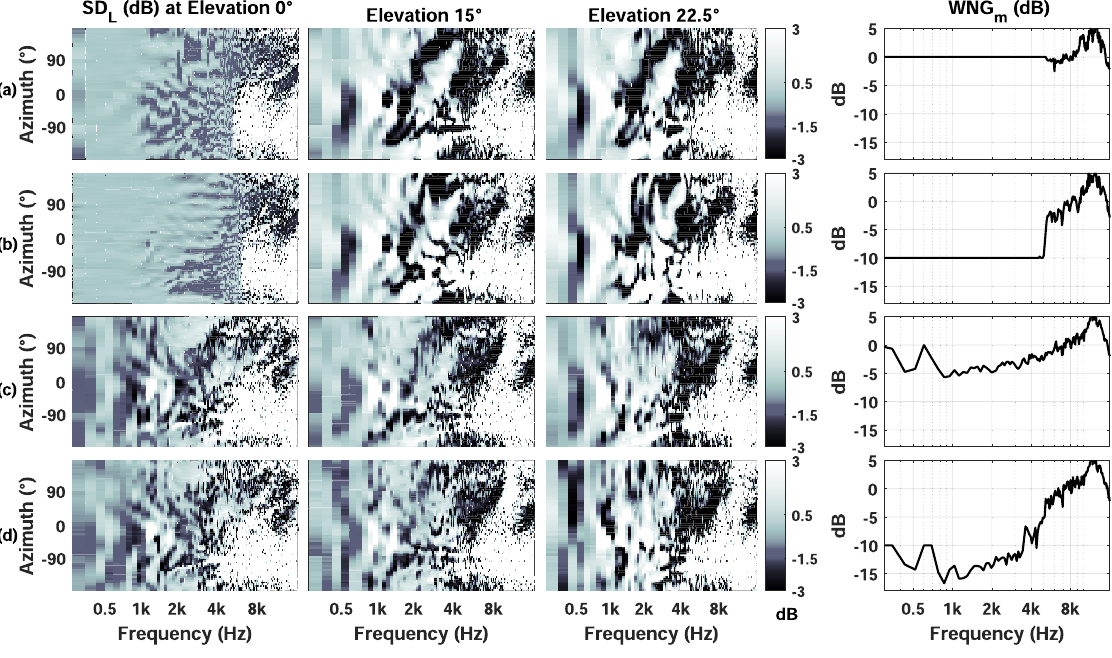
Figure 2. The resulting SD at elevations 0 (cid:3) , 15 (cid:3) and 22.5 (cid:3) (the fi rst three columns from left) and the resulting WNG m (the right column). The spectral weights were calculated with (a): V0/ b 0 , (b): V0/ b (cid:4) 10 (c): V0 ± 15/ b 0 , (d): V0 ± 15/ b (cid:4) 10 . The results are shown for the left ear of subject 1 in this